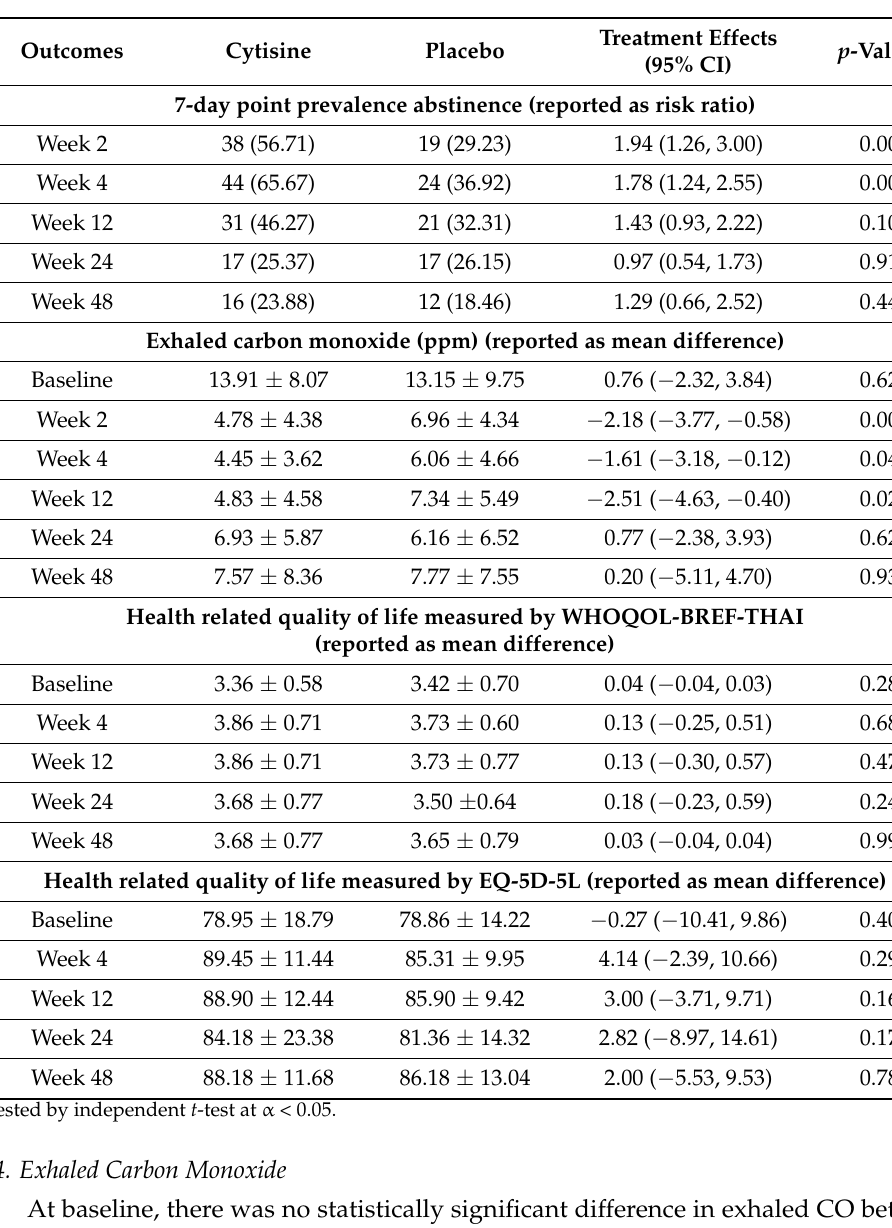
Table 3. Results for secondary efficacy